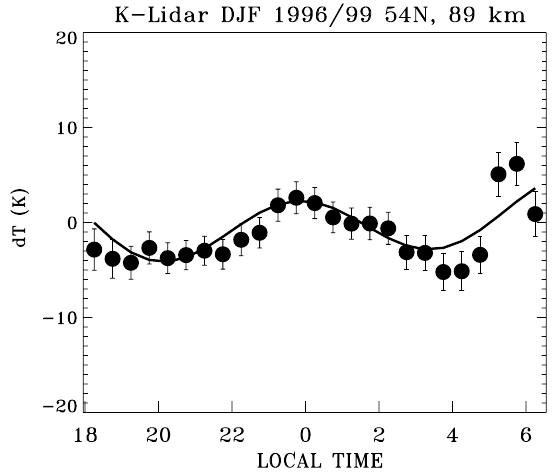
Fig. 2. Potassium lidar temperature semidiurnal and terdiurnal tidal fits at 54 ◦ N and 89km height for winter solstice (December, Jan- uary, and February). The temperature data are three-year compos- ites from 1996 to 1999 fitted simultaneously to 12-h and 8-h tidal harmonics (solid